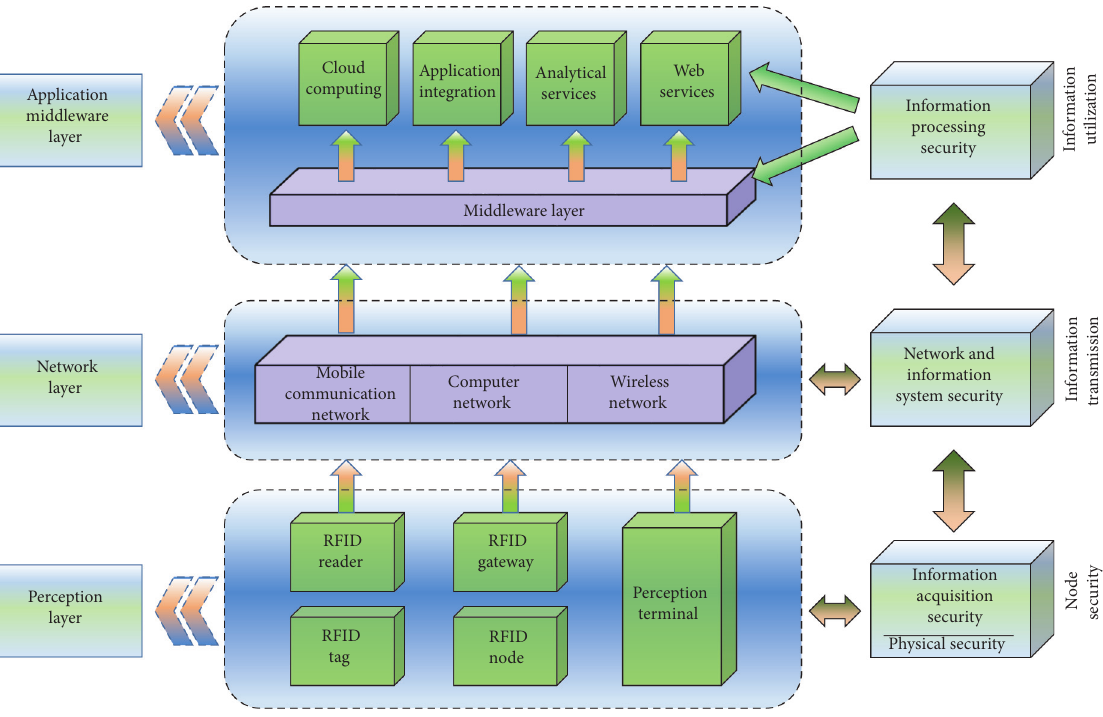
Figure 3: System structure diagram of Internet of things (IoT).